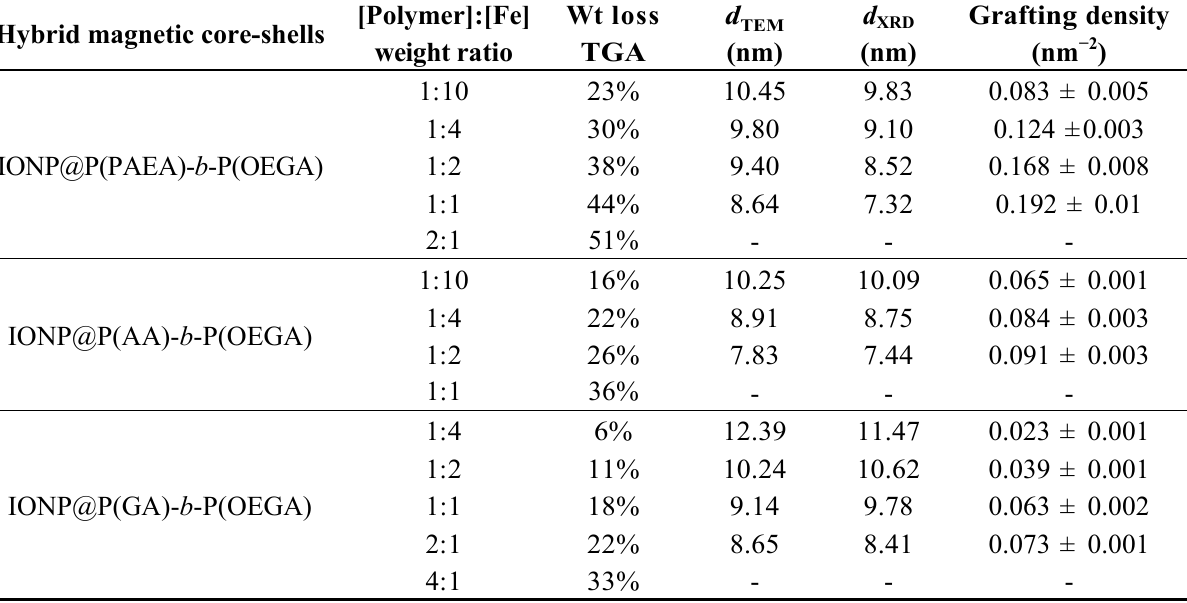
Table 4. Summary of weight loss TGA results and particle size ( d polymer-coated IONPs at different polymer-to-iron ratios [35]. PAEA: phosphonic acid ethyl acrylate. Copyright 2014 Royal Society of